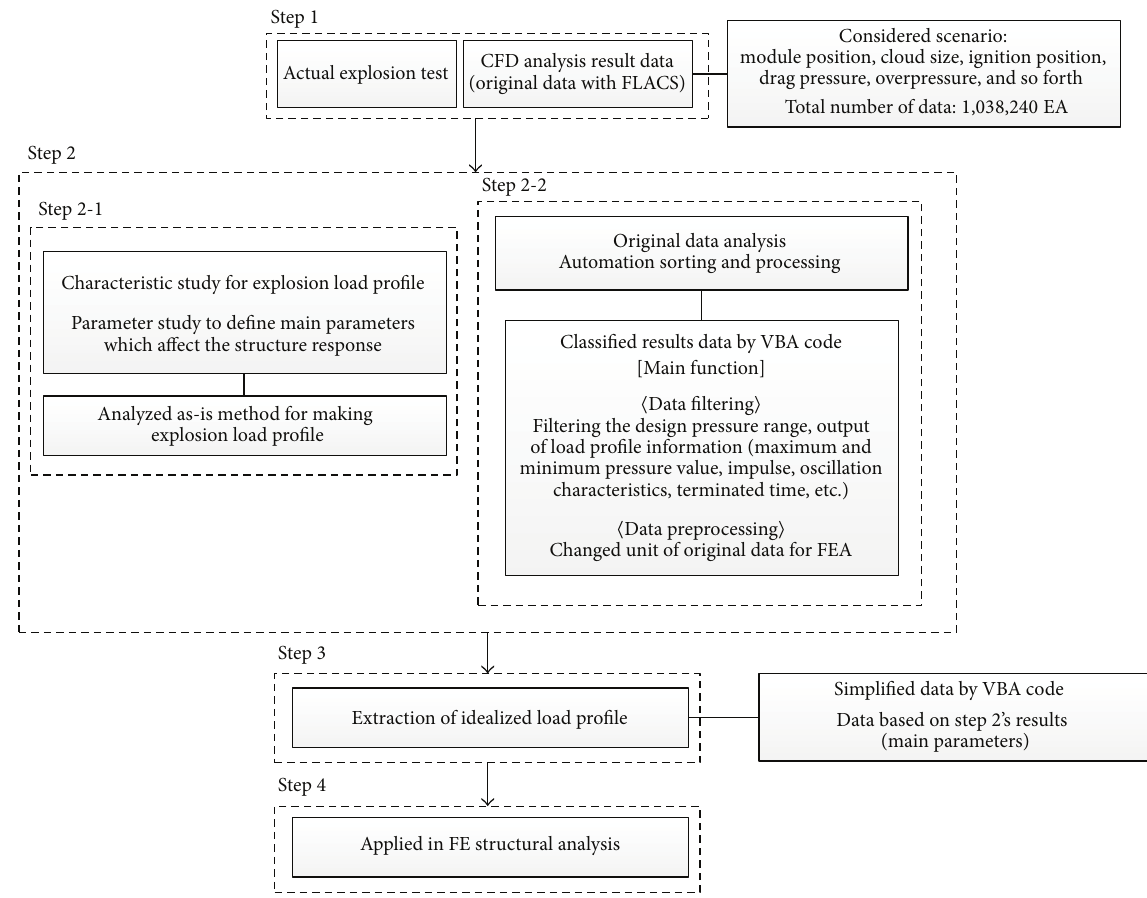
Figure 2: Algorithm for gas explosion data analysis using developed VBA code.